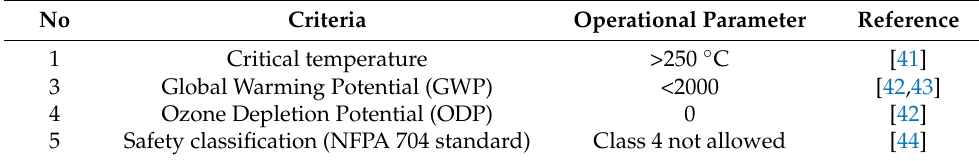
Table 2. Selection criteria of the working